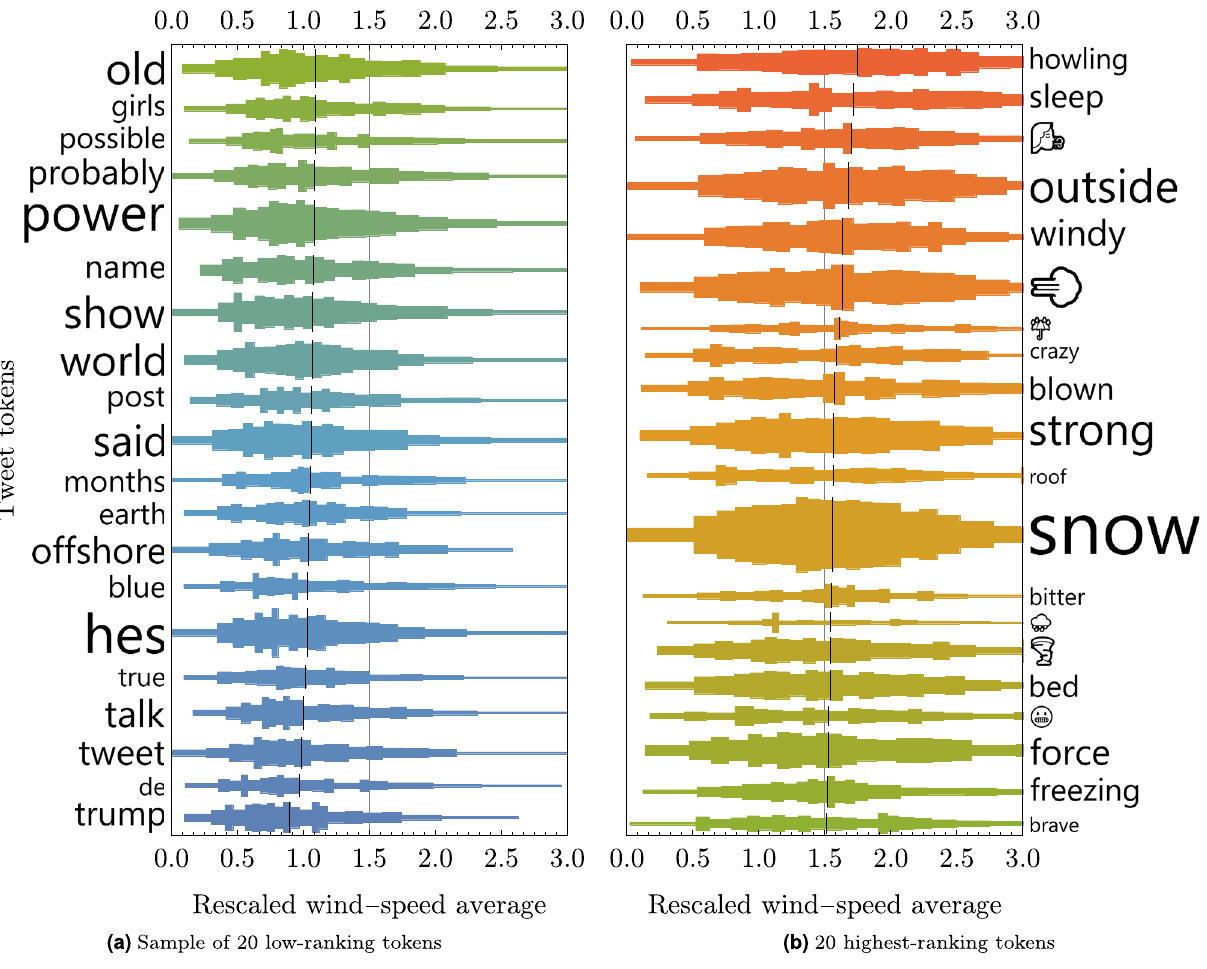
Figure 6. Distributions of wind speeds associated with a selection of words and emojis. Wind speed values are average wind speeds at the nearest weather station in the 6 hours prior to each tweet’s creation. Distributions are compiled from the set of all tweets containing each